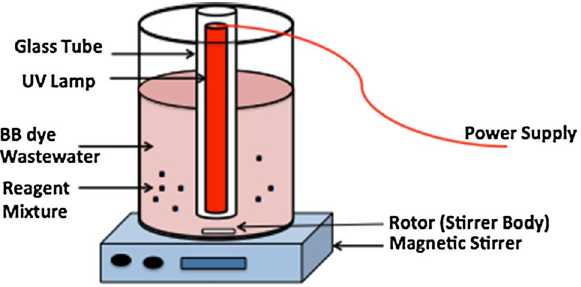
Fig. 1 Scheme methodology of nano-photo-Fenton